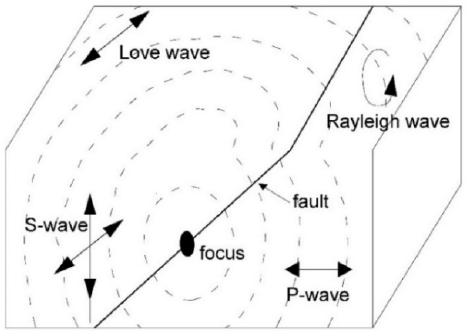
Figure 4. The direction of body waves generated by earthquakes.